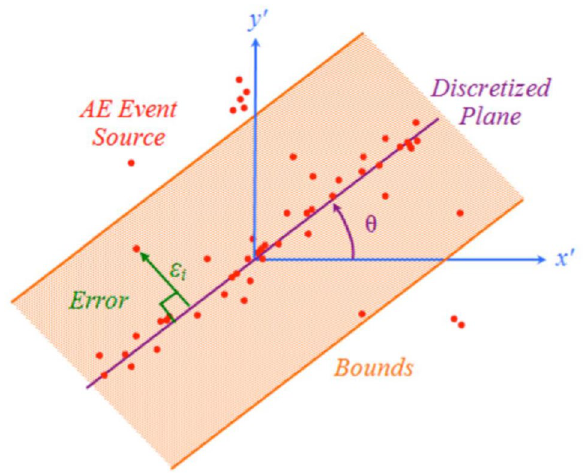
Fig. 2 Error estimation from the perpendicular distance of each indi- vidual AE event to the fracture plane within a set of bounds. The x ′ and y ′ axes are the principal axes associated with the lowest error pitch orientation of the assumed plane. The plane is then rotated in increments of Δ θ to perform an error estimation under each orien- tation. ε i is the perpendicular distance between AE event ( i ) and the assumed fracture